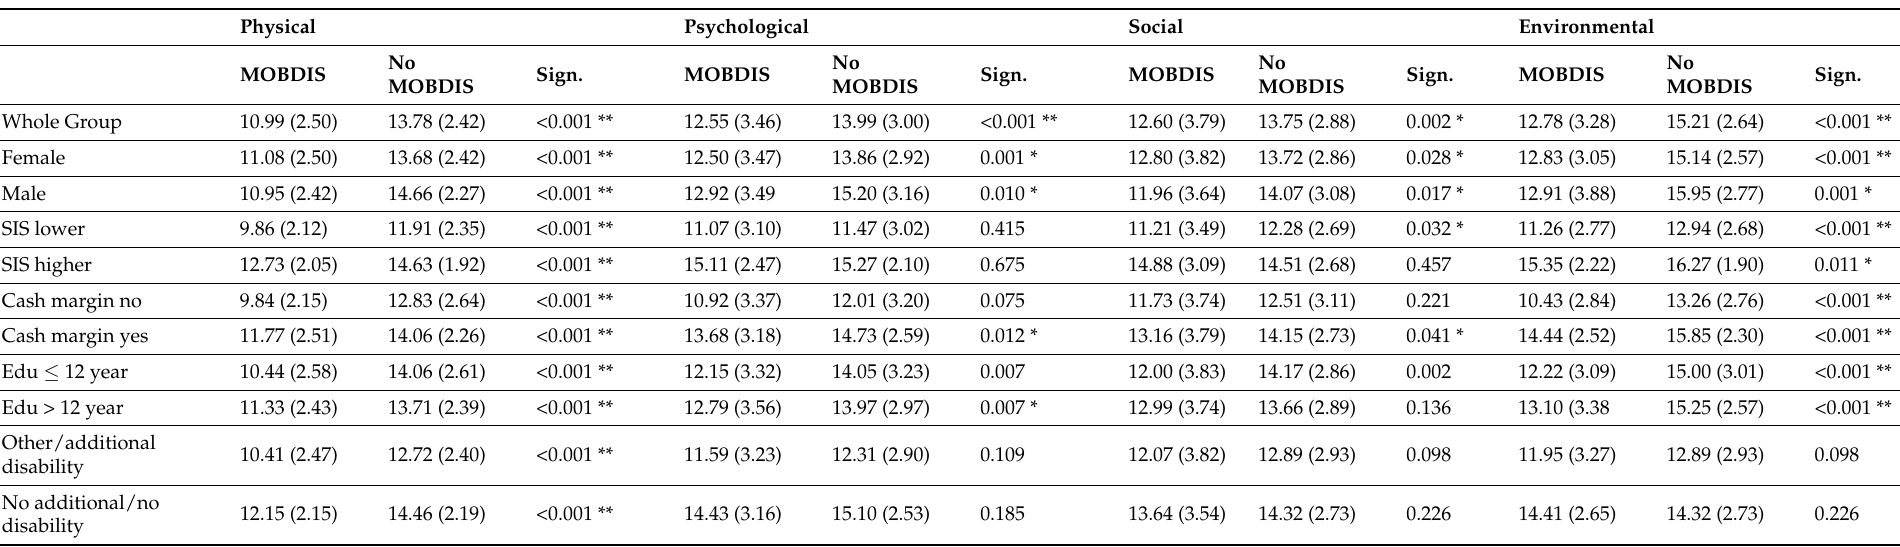
Table 3. Between-group comparison for WHOQOL-BREF domains, [mean (SD)] p -value for Welch t-test (two-sided).